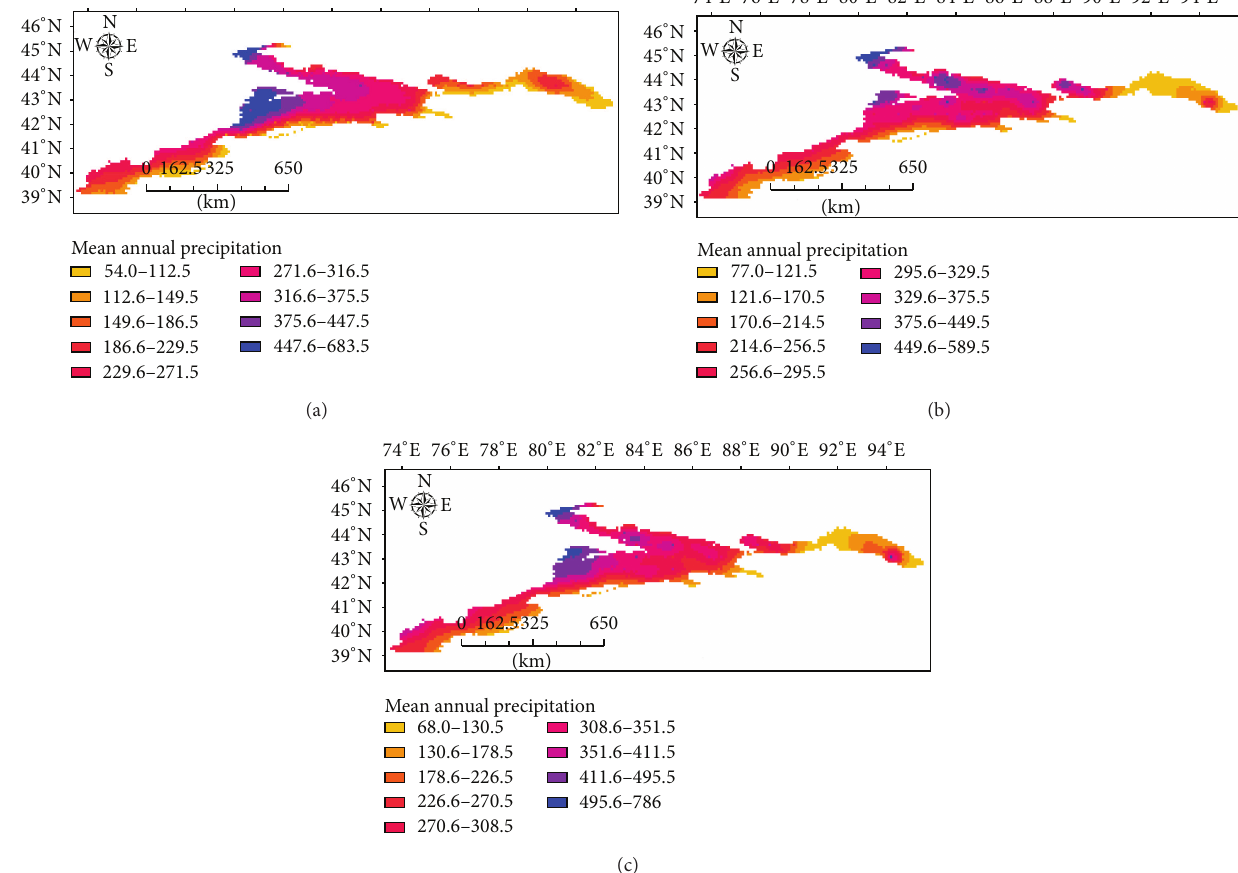
reverse to that of correlation coefficient (Figure 3(b)); namely, higher RMSE can be obtained over the high precipitation area while correlation coefficient would be lower. On the contrary, the spatial distribution of RMSF presents good consistency with that of correlation coefficient (Figure 3(c)), which means the two databases work well in low mountainous area but fail in the area where orographic precipitation has a greater influence on the amount of